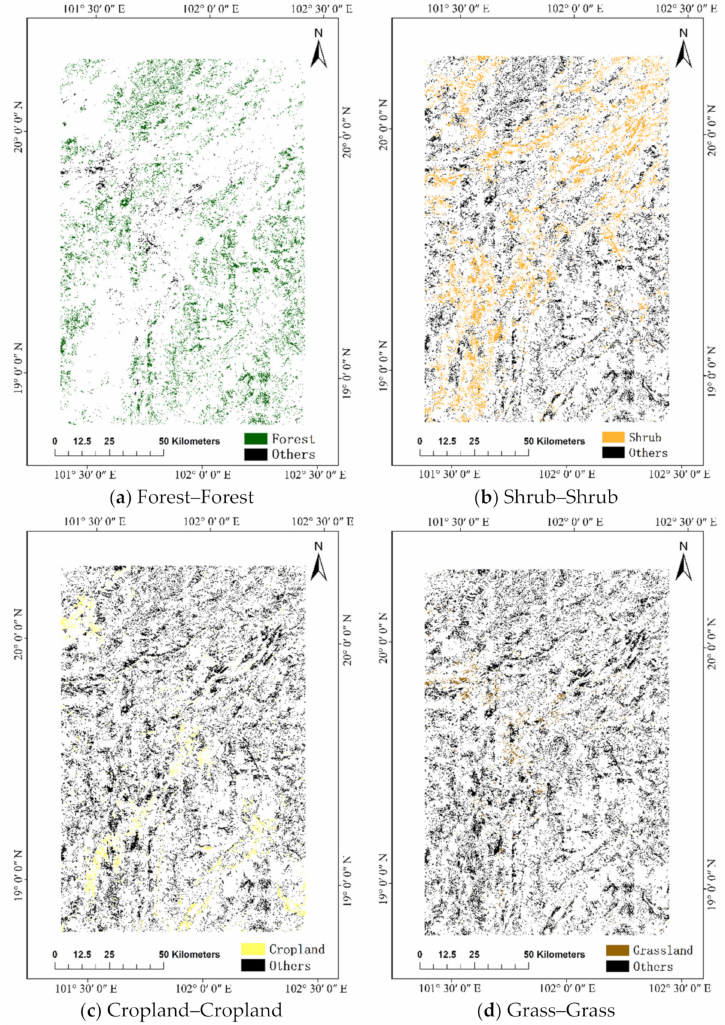
Figure 15. Spurious changes in ( a ) forests transformed into forests; ( b ) grass transformed into grass; ( c ) cropland transformed into cropland; ( d ) shrubs transformed into